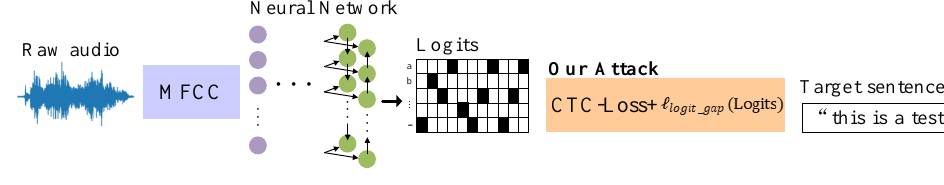
Figure 1. Logits-Traction